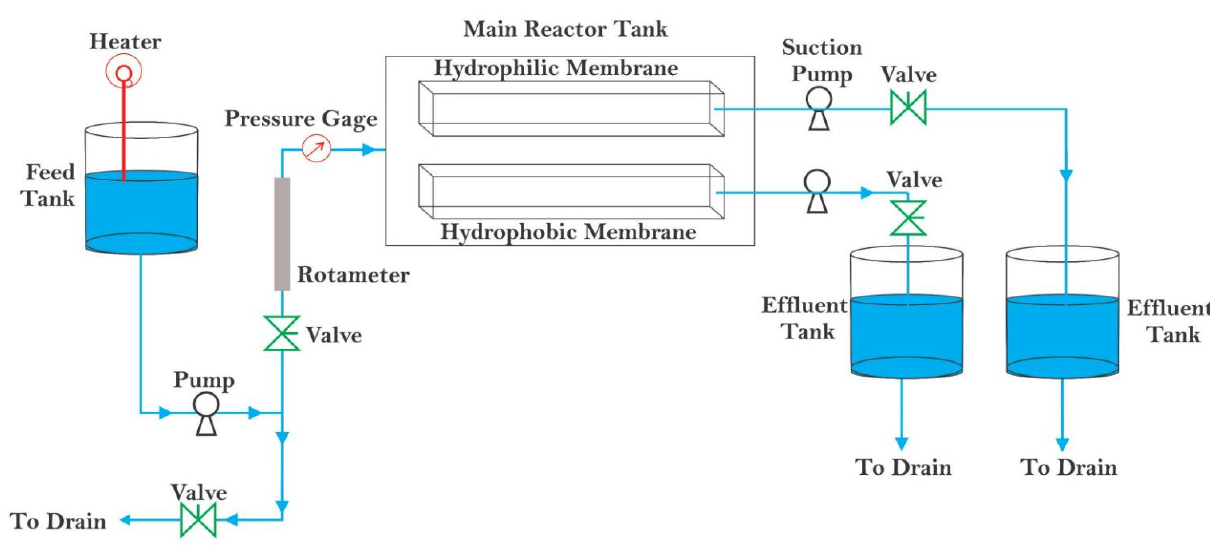
Figure 1. Schematic diagram of the microfiltration process.